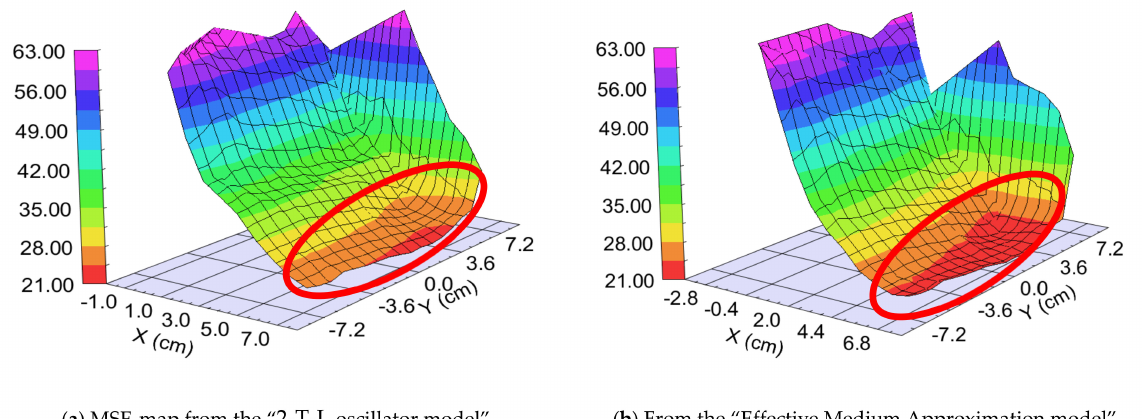
Figure 16. Mean Squared Error (MSE)-maps ( a ) using the2-Tauc-Lorentz (2-T-L) oscillator model ( b ) and the Effective Medium Approximation model. Red ellipses show the interesting area, where the composition changes the most. We show only one 15 × 15 cm part, all other parts show the same